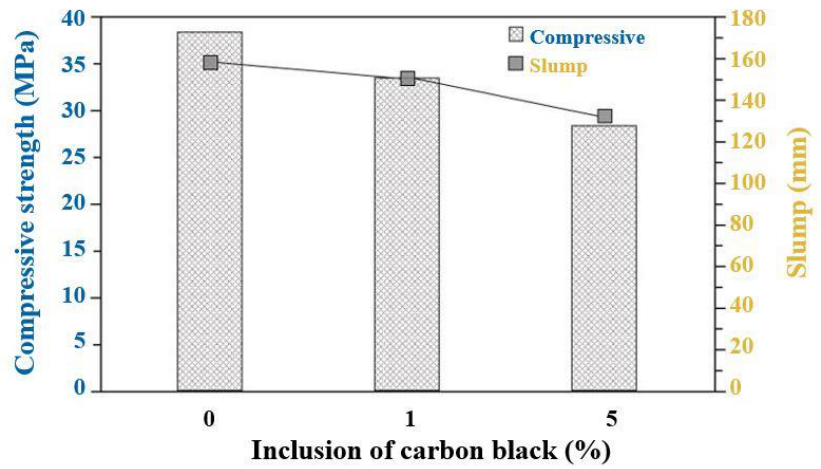
Figure 3. Compressive strength and slump of concrete.